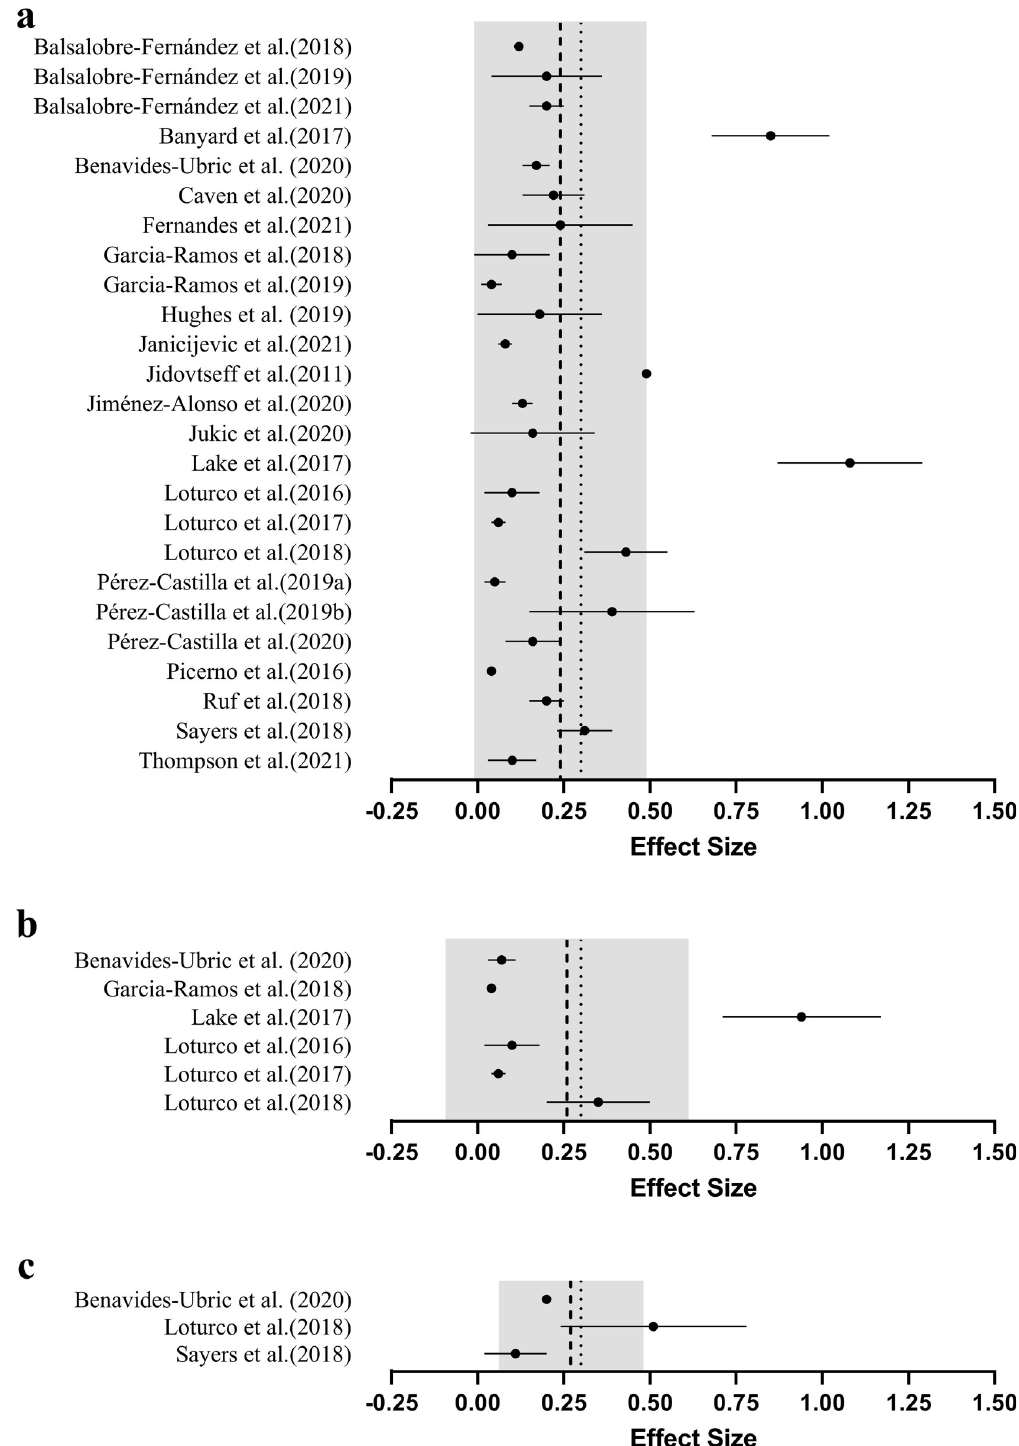
Fig 5. Mean ( ● ) effect sizes ( ± SD), grouped average (---) and recommended maximum effect size ( ��� ) for magnitude of difference between predicted and actual 1RM by velocity metric used for maximal strength prediction; a.) mean concentric velocity, b.) mean propulsive velocity, c.) peak concentric velocity. The grey band represents the standard deviation of the pooled effect sizes. Note : Effect sizes closer to zero indicate greater validity (i.e., smaller difference between actual and predicted